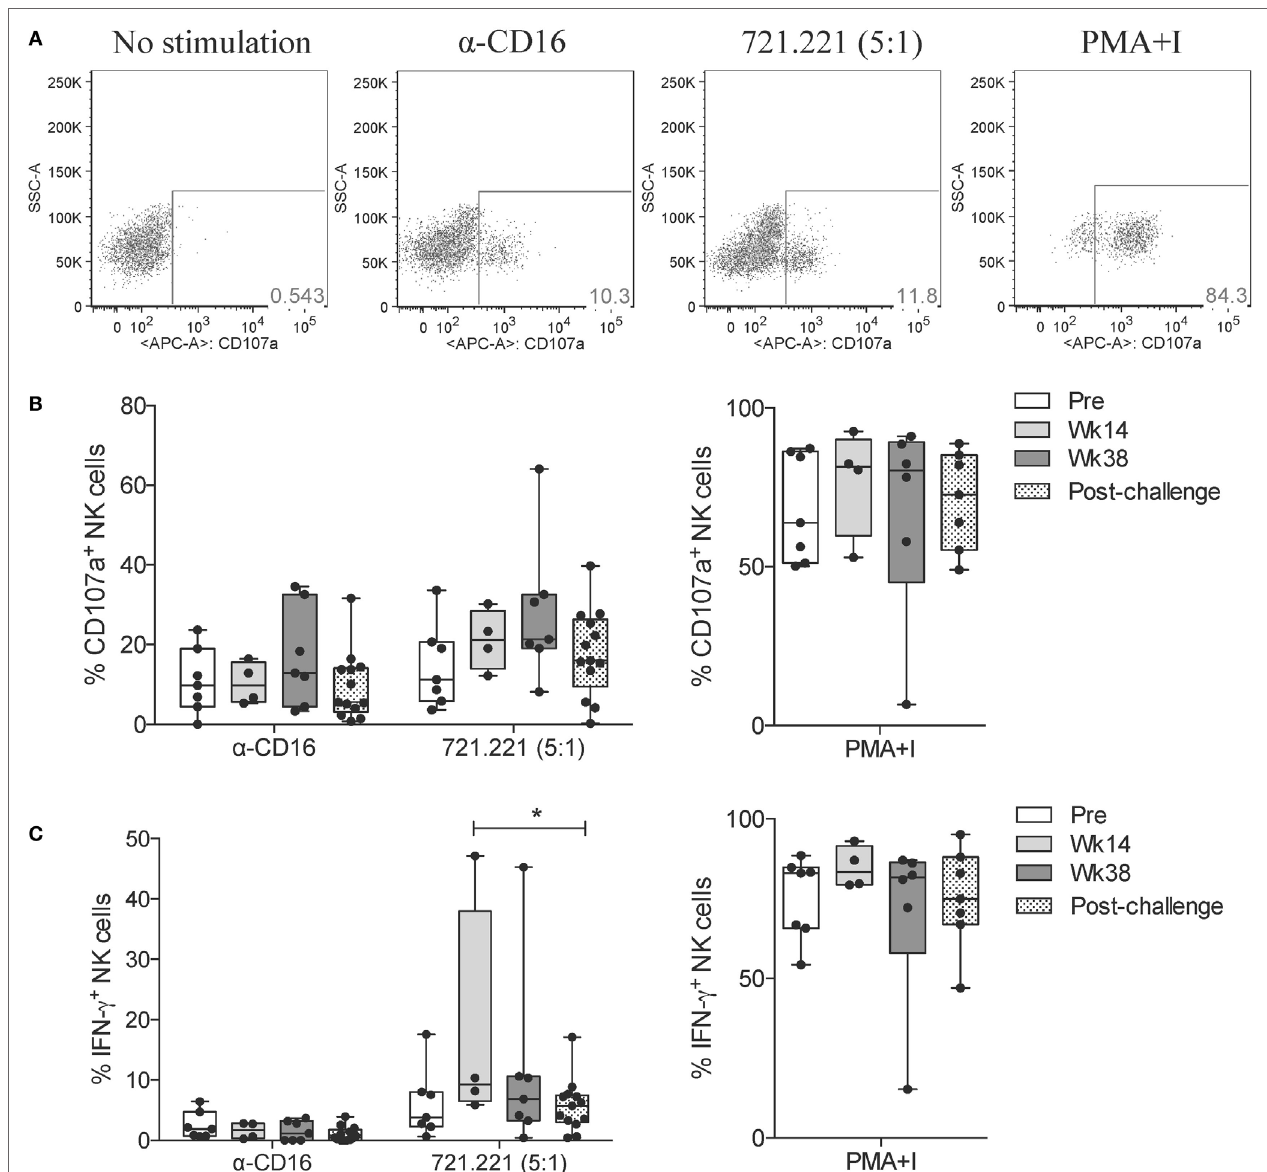
FigUre 5 | nK cell cytotoxic responses through vaccination and after siV infection . Frozen PBMCs obtained over the course of vaccination and challenge were thawed, cultured overnight, and then stimulated for 5 h with anti-CD16 antibody, 721.221 cells (5:1 effector-to-target cell ratio) or PMA plus ionomycin. (a) Representative flow cytometry dot plots displaying the proportional abundance of CD107a + cells within total NK cells (CD3 − CD8 + NKG2A + ) for each stimulatory condition. (B,c) Expression of CD107a (B) and production of IFN- γ (c) by total NK cells in response to each stimulation was quantified at the indicated time-points. Values of non-stimulated samples and negative controls have been subtracted. Data are shown as minimum to maximum boxes with all data points represented. * p < 0.05 indicates statistically significant differences between the indicated time-points by Mann–Whitney